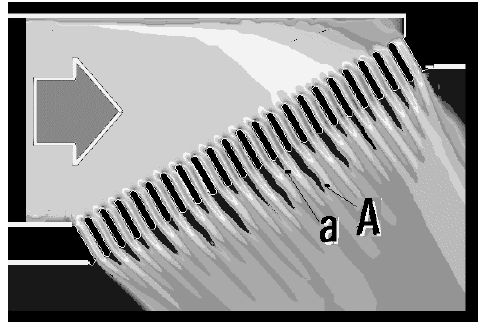
Fig. 17. Computed distribution of specific kinetic energy of flow in the domain of Fig. 16. In contrast to the flowfield driven by the jet (Fig. 11) the main part of the cascade members are exposed to the same inlet